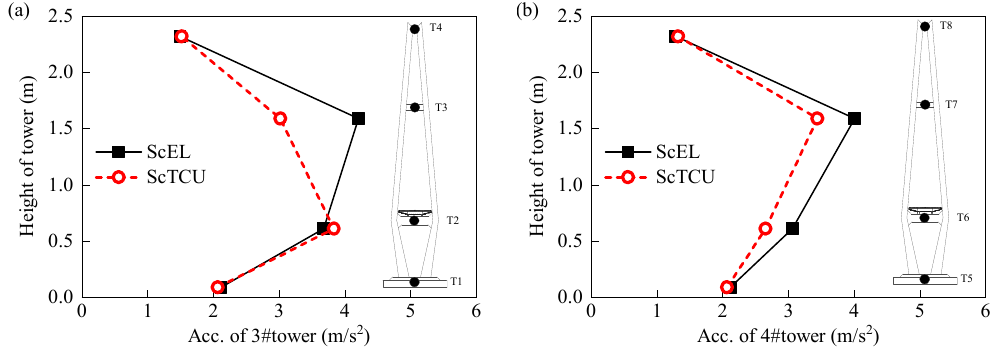
Figure 14. Maximum acceleration responses ( a ) 3# tower; ( b ) 4# tower.